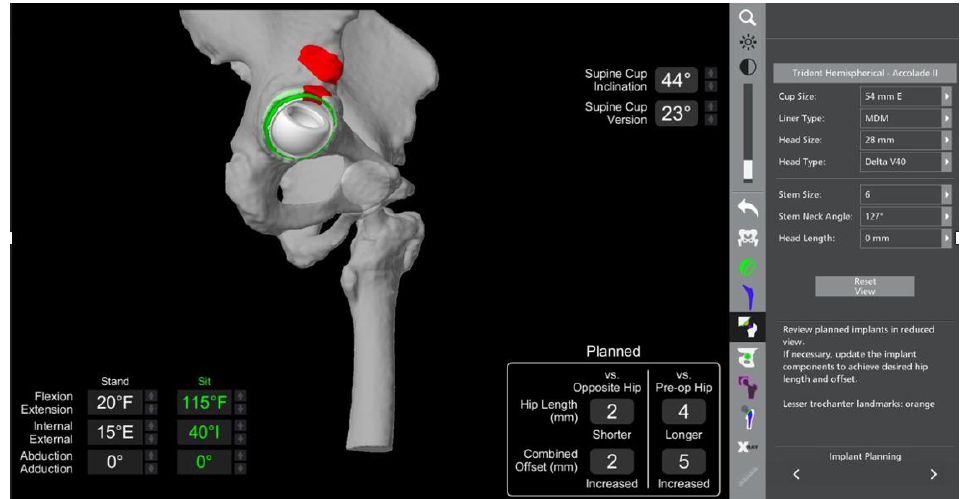
Figure 8. Bone-on-bone and implant-on-bone impingement in the postero-superior region of the acetabulum (in red) in deep flexion/external rotation.